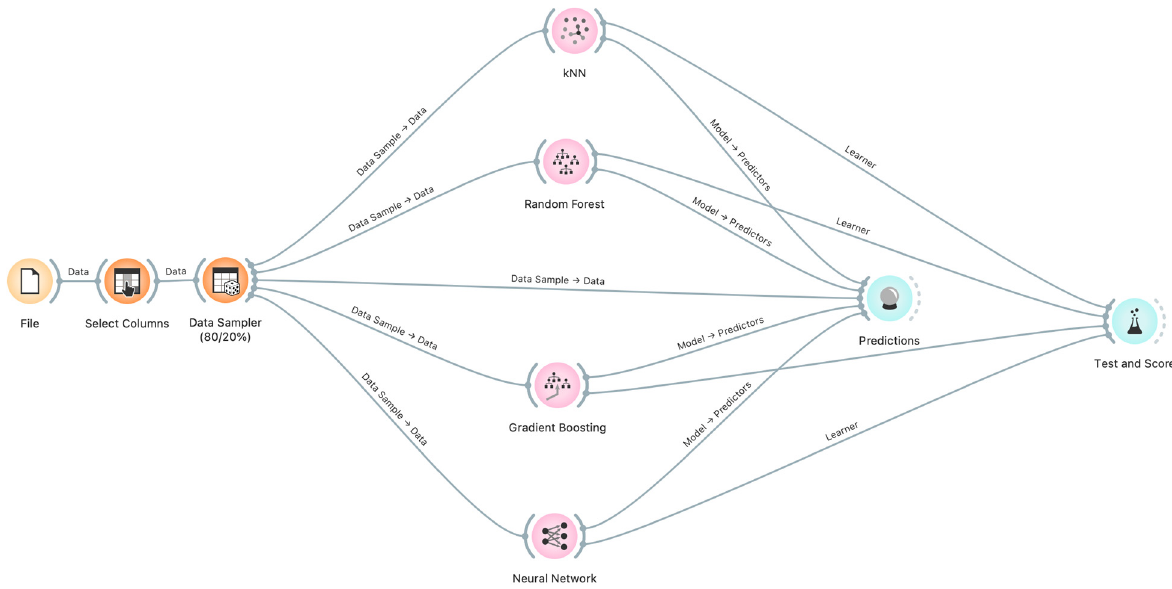
Figure 4. The machine learning algorithms for output variables